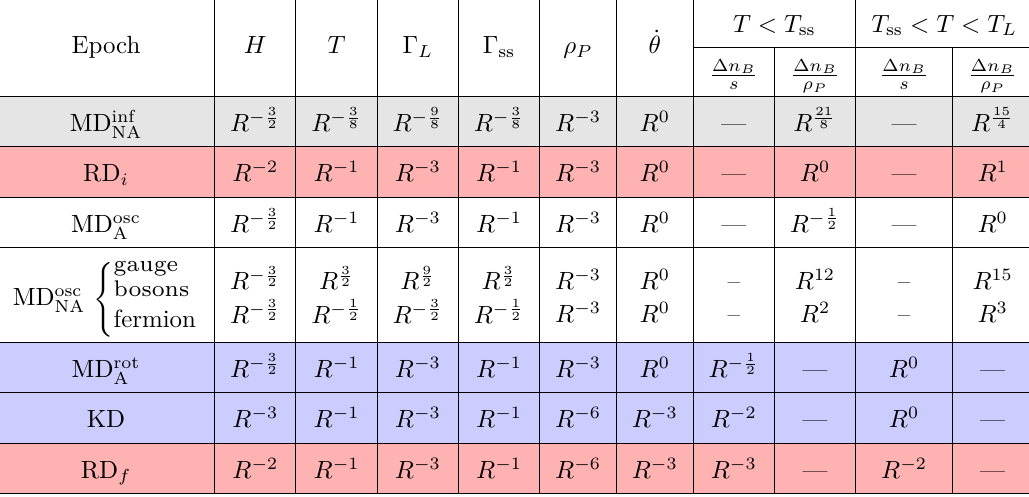
Table 2 . Scalings of physical quantities relevant for the estimation of the baryon asymmetry. through the white rows MD osc . In this case, the MD rot and KD eras in the blue A , NA A